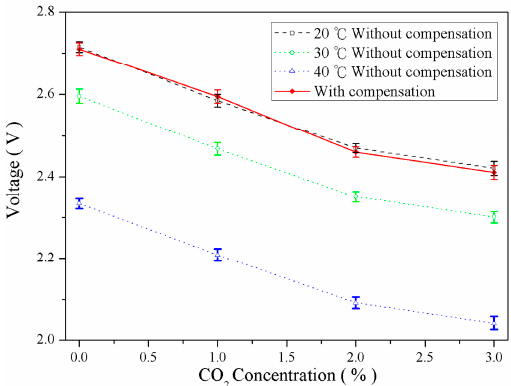
Figure 12. Comparison of CO 2 concentration–voltage response relationships before and after temperature compensation.